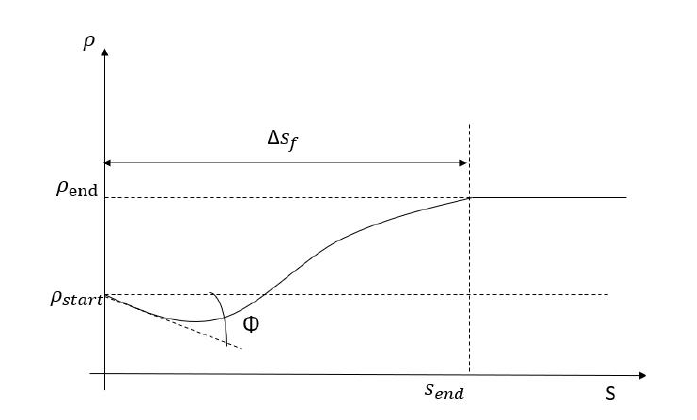
Figure 5. Boundary conditions in the s − ρ coordinate system: path candidate from the offset between ρ start and ρ end .